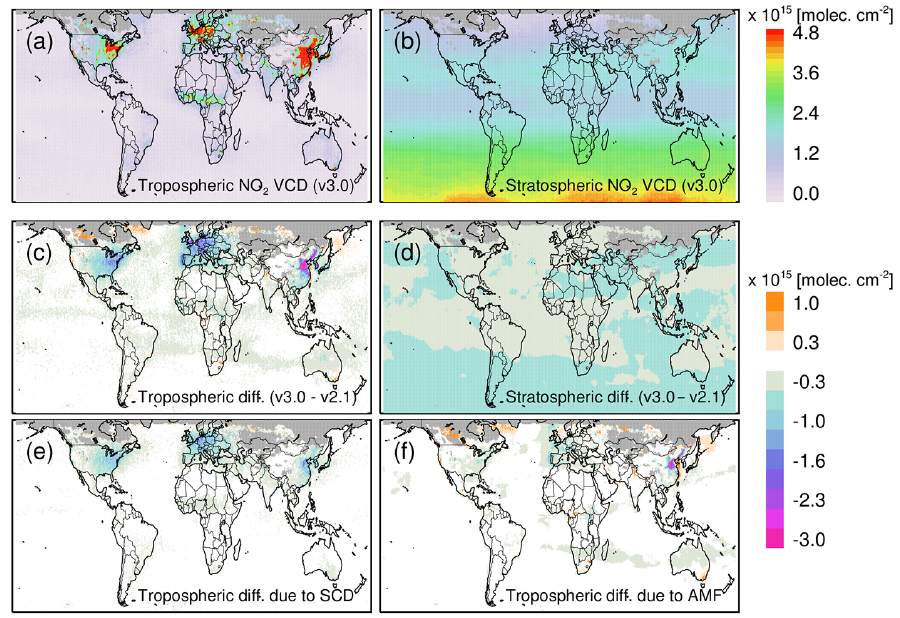
Figure 3. OMI NO 2 maps (a, b) and difference maps (c, d) for December 2006: tropospheric VCD ( V trop : a, c ) and stratospheric VCD ( V strat : b, d ). Bottom row: change in V trop due to new SCD only (e) , and change in V trop due to new a priori NO 2 profile shapes only (f) . Similar maps for July 2006 are shown in Supplement Fig. S1.